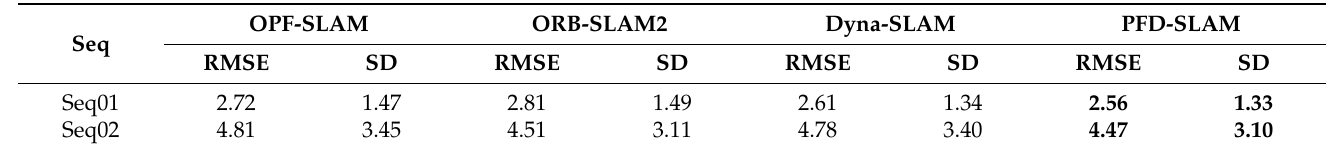
Table 7. Comparisons of RPE-RMSE (deg/s) in rotational drift in real scenes.